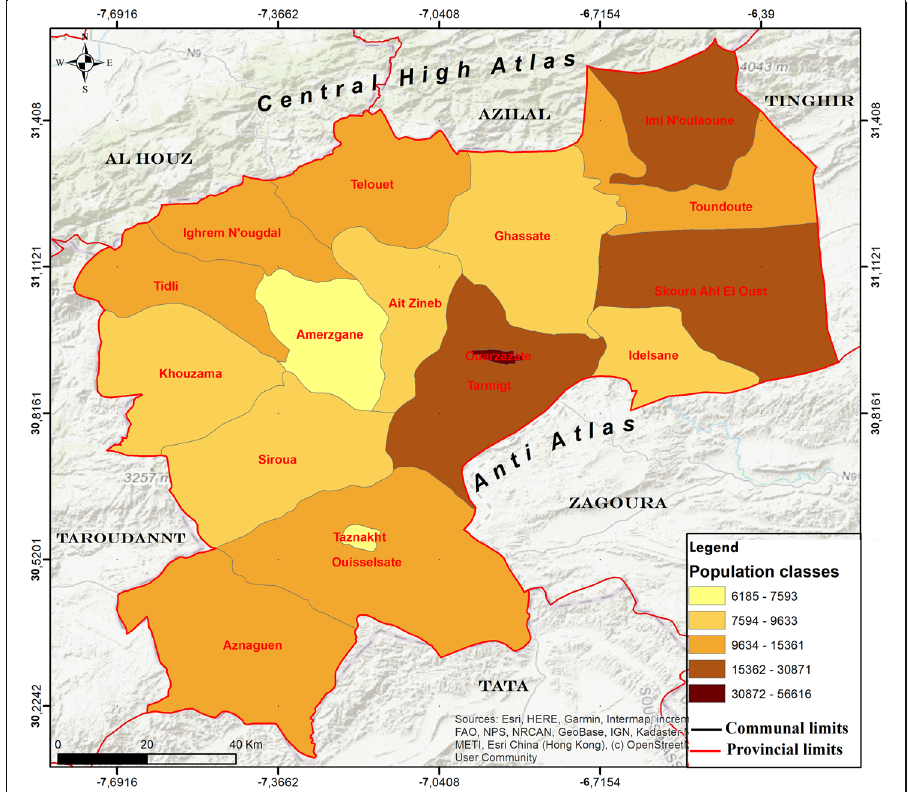
Fig. 7 Map of population density at the municipal